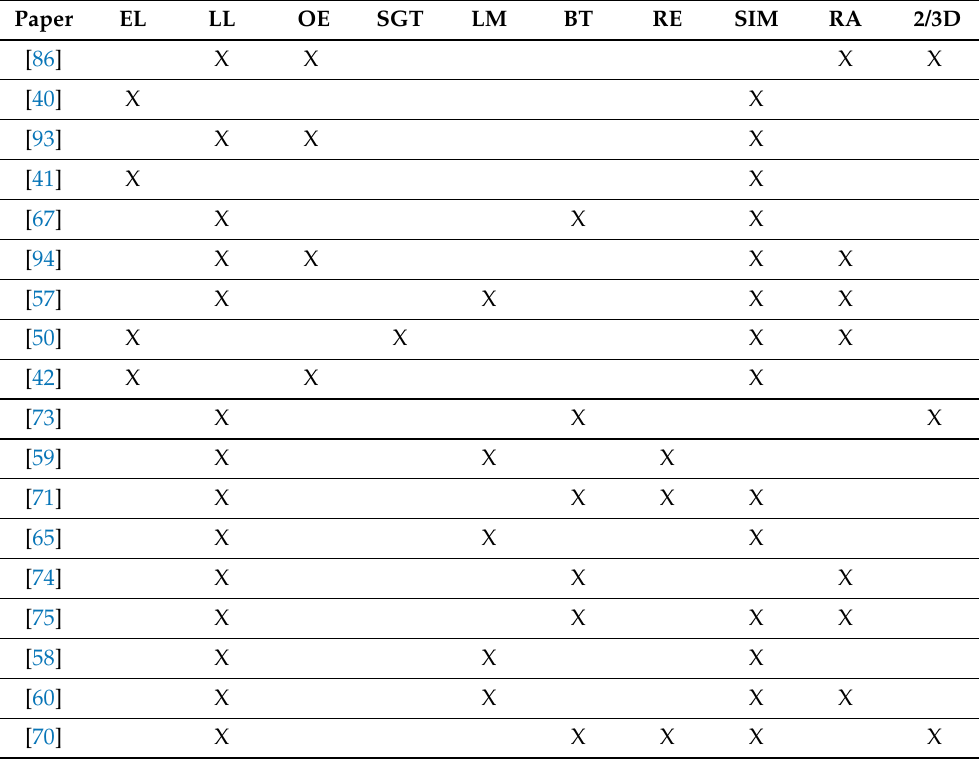
Table 1. An overview of state estimation developments (left column lists the papers by chronological order, while the other columns indicate the methodology and the type of applications—EL: